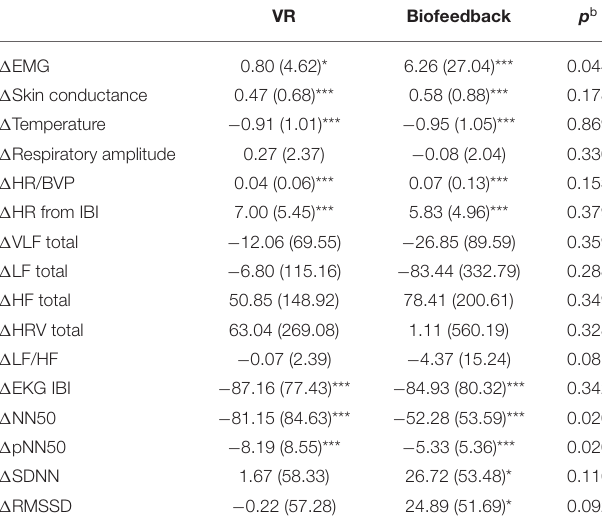
TABLE 4 | Changes of physiological parameters from the stress phase to the relaxation phase according to the type of relaxation session in the responders a ( n = 39). VR